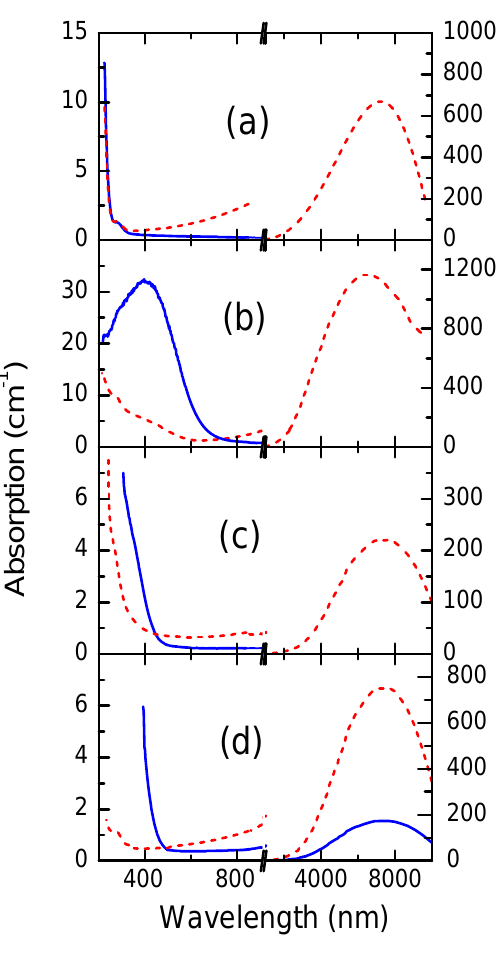
Figure 1. Absorption spectra of ( a ) CdF (solid line) and after (dotted line) additive coloration, and spectra of ( b ) CdF = 4 × 10 18 cm − 3 ); ( c ) CdF ( N In ( N = 1.7 × 10 18 cm − 3 ) additively colored crystals cooled in the dark down to T = 77 K Ga (solid lines) and the same crystals after subsequent illumination in the UV-VIS absorption band at the same temperature (dotted